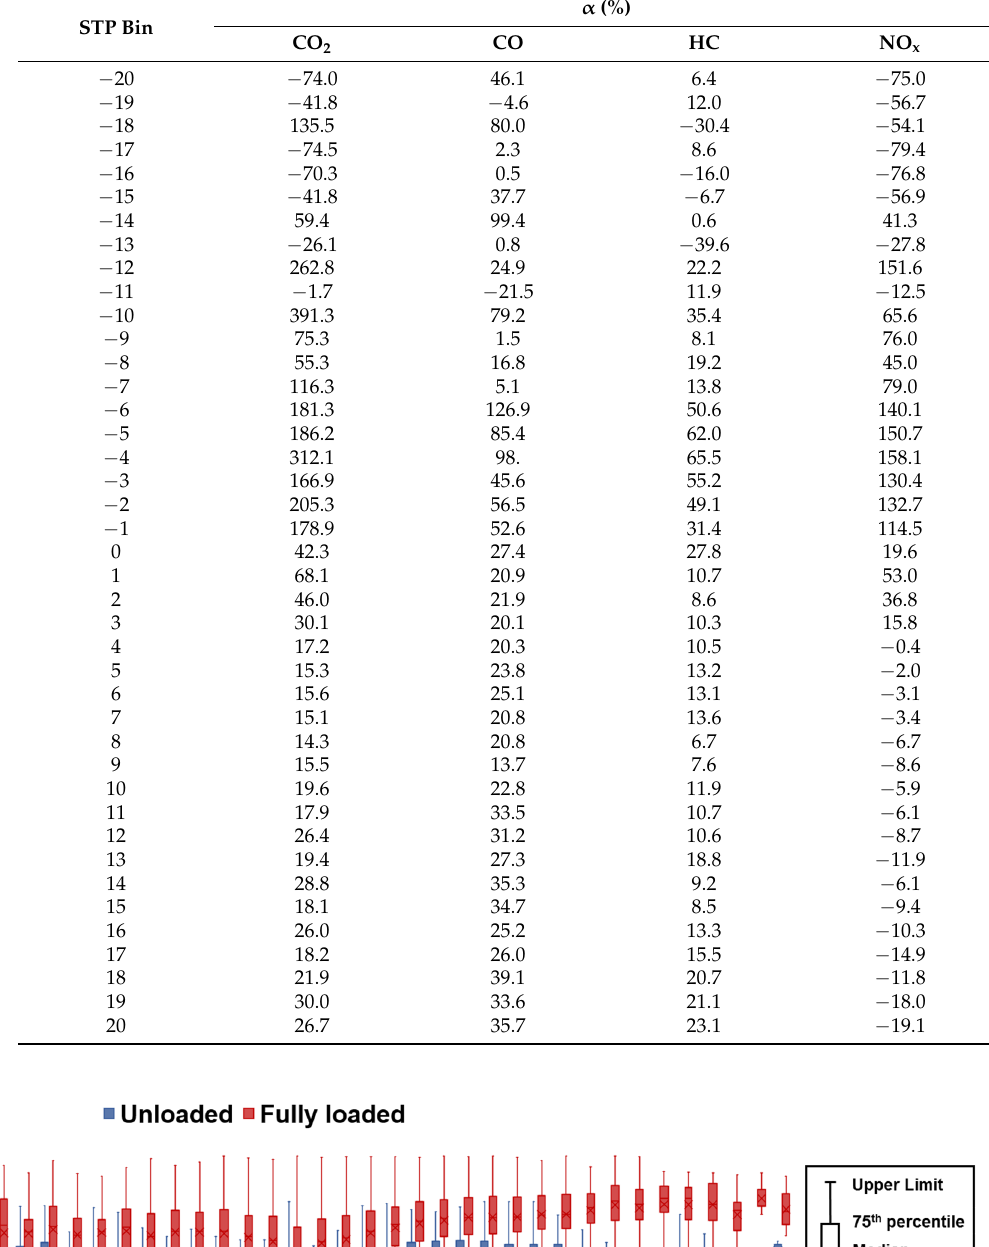
Table 3. The difference in emission rate under different loading conditions.